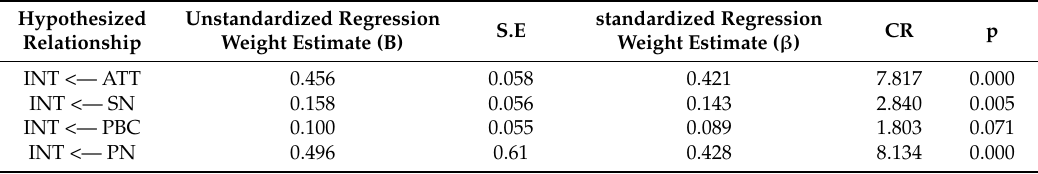
Table 7. Unstandardized and standardized regression weight in the hypothesized path model 2. Hypothesized Unstandardized Regression standardized Regression S.E CR p Relationship Weight Estimate (B) Weight Estimate ( β ) INT <— ATT 0.456 0.058